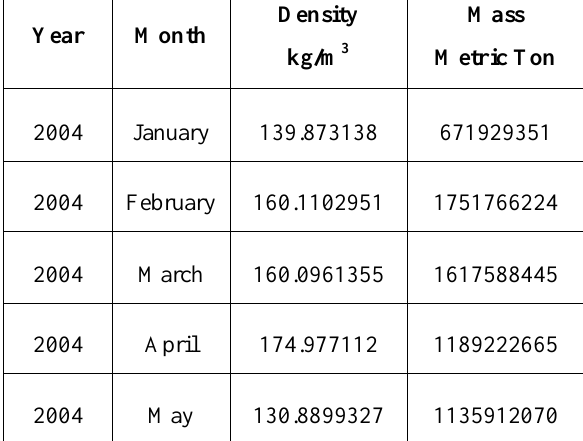
Table 3: An overview of snow mass balance calculations for year 2004